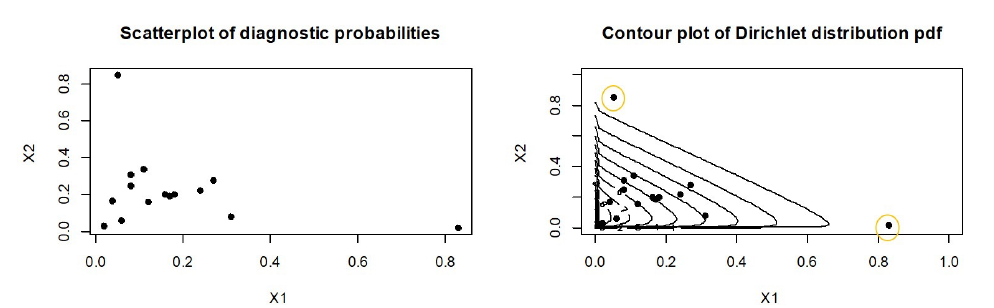
Figure 1. Plots of the data and the Dirichlet distribution on the diagnostic probabilities data